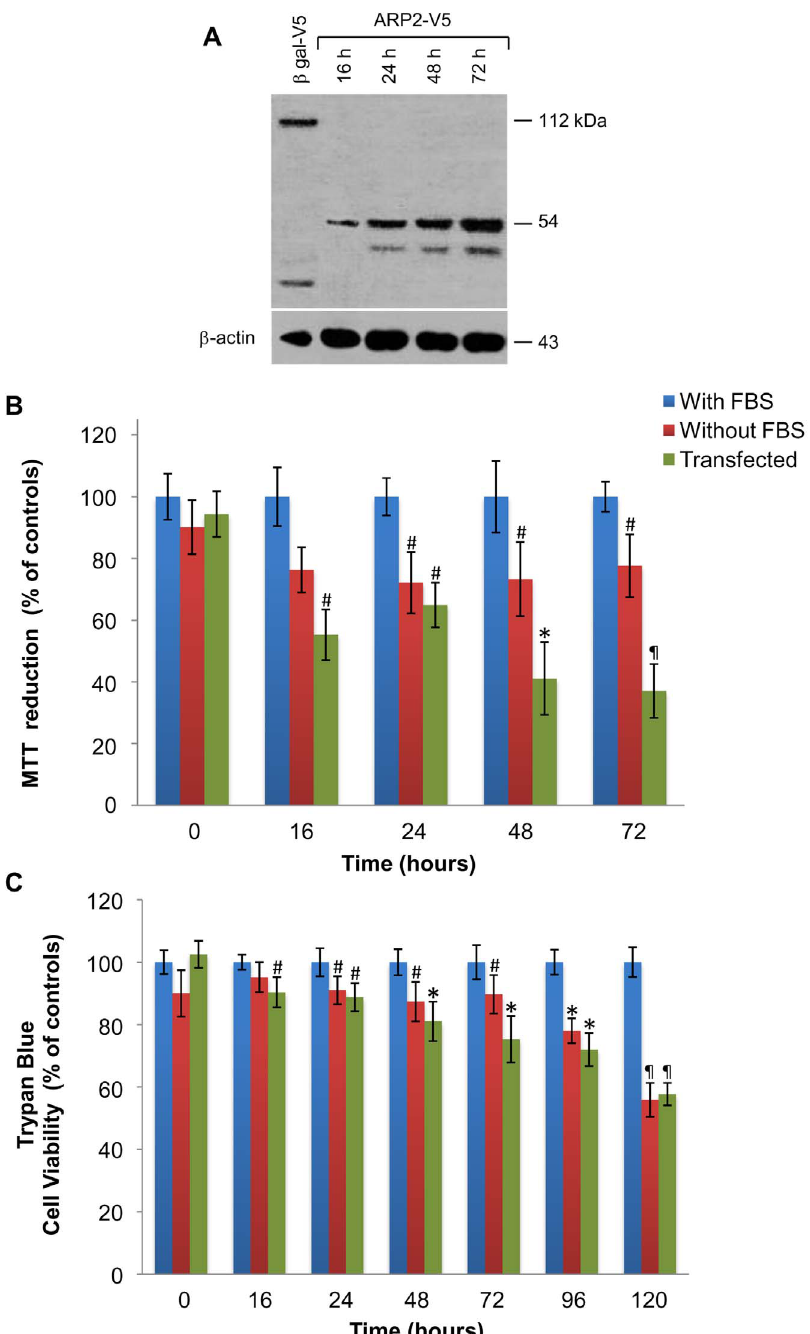
Figure 1. ARP2 expression induces apoptosis in LNCaP cells. ( A ) Western blots detected expression of b -gal-V5 (112 kDa) and ARP2-V5 (54 kDa) in total cell lysates. ( B ) Normalized cell viability% of controls was assessed using MTT assays with 2 6 10 4 cells cultured in the absence of serum or transfected with arp2 cDNA. Viability of these two treatment groups were assayed at 16, 24, 48, and 72 h timepoints. ( C ) Normalized cell viability% of controls assayed using a trypan blue exclusion method. Cells were cultured in the absence of serum or transfected with arp2 cDNA and assayed at 16, 24, 48, 72, 96, and 120 h timepoints. Mean values are presented (n=3, X 6 S.E.M), # p , 0.05, * p , 0.01, " p , 0.001 compared to control